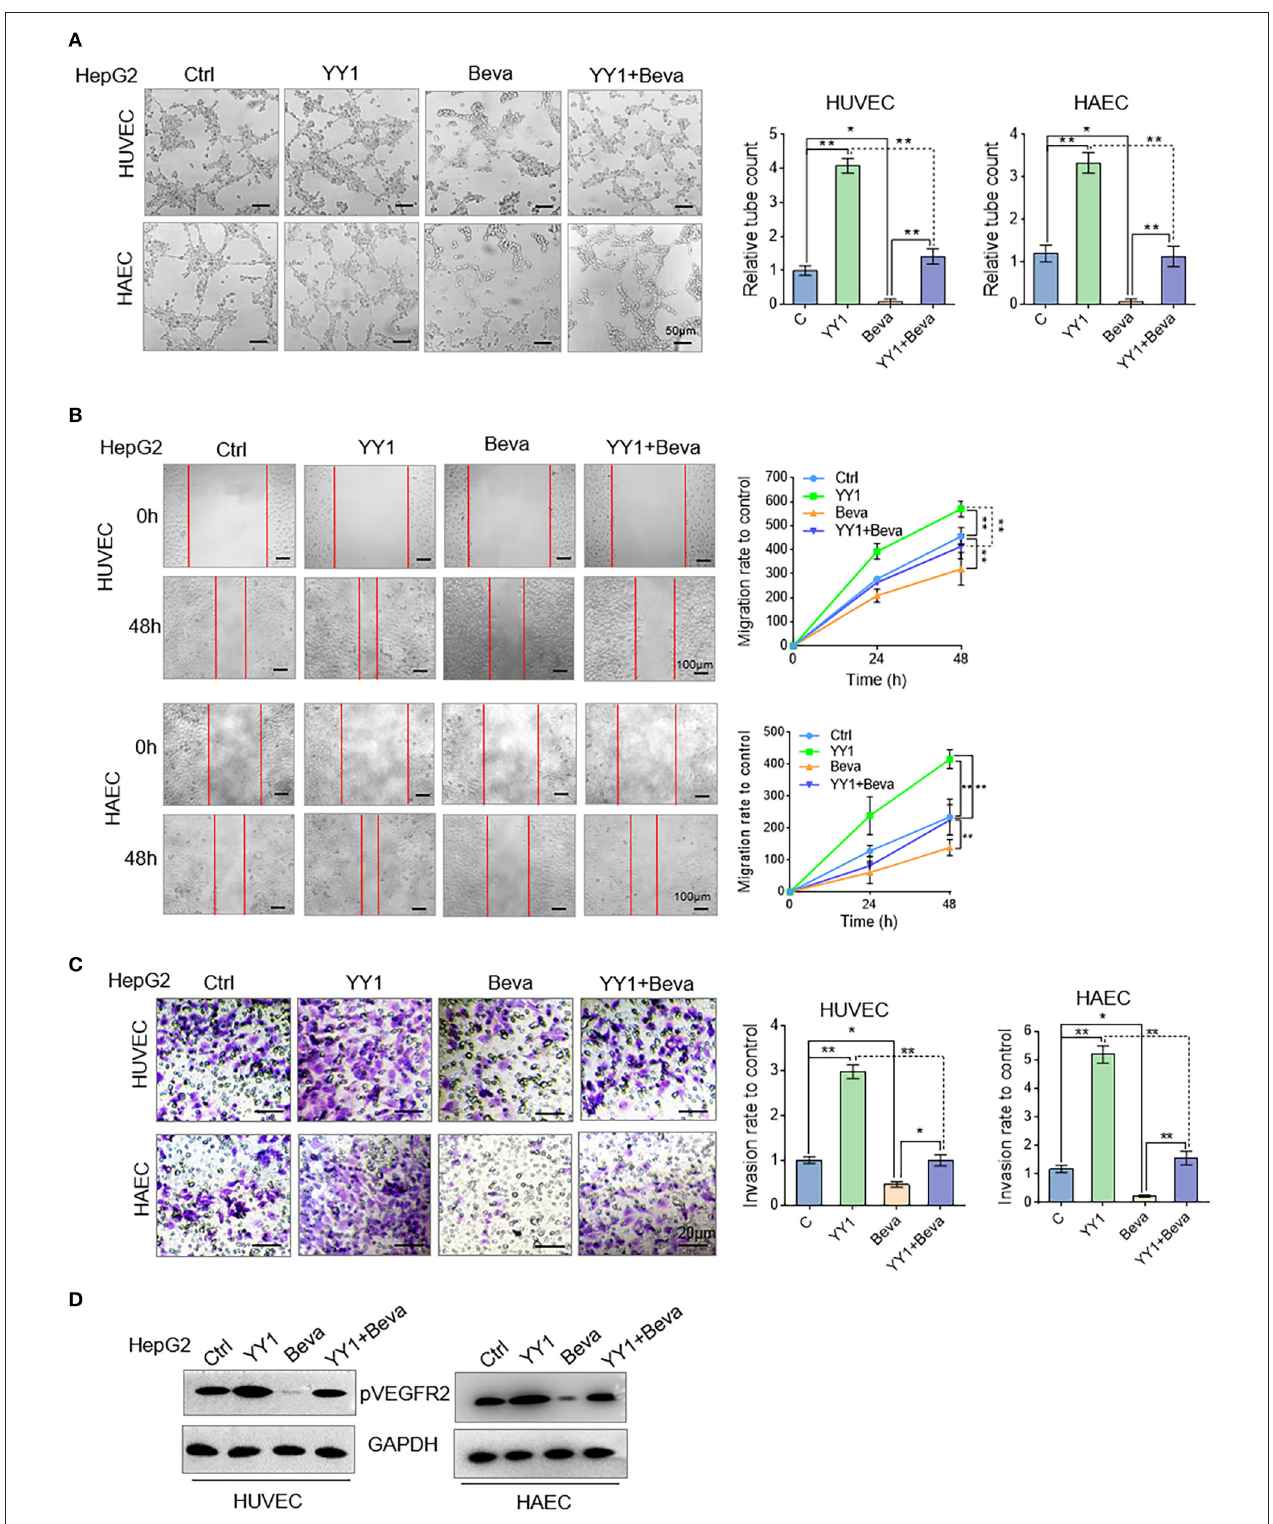
FIGURE 5 | Bevacizumab blocked the promotive effect of YY1 on tube formation through VEGFA. (A) Tube formation of HUVECs and HAECs cultured in the indicated cells treated with or without bevacizumab or transfected with YY1. Scale bar = 50 µ m. (B,C) Migration and invasion of HUVECs and HAECs cultured in the indicated cells treated with or without bevacizumab or transfected with YY1. (D) WB analysis showed pVEGFR2 expression levels in HUVECs and HAECs treated with conditioned media. * P < 0.05, ** P < 0.01.